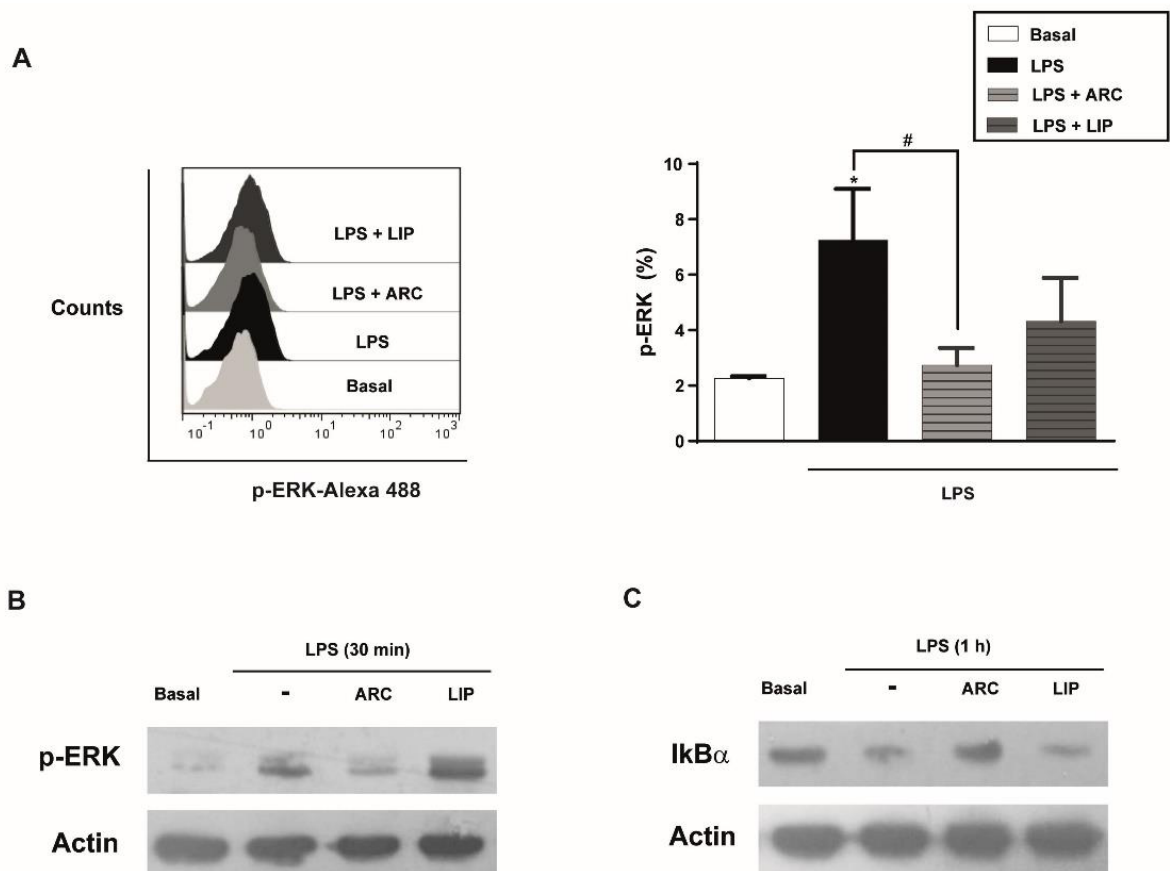
Figure 7. ARC attenuate LPS-induced phosphorylation of extracellular signal-regulated kinase (ERK1/2) and activation of NF- κ B pathway in endothelial cells. ( A ) HMEC were stimulated with LPS (1 µ g/mL) in the absence or presence of nanovesicles for 30 min, labeled with anti-p-ERK and analyzed by flow cytometry (one-way ANOVA followed by Bonferroni multiple comparisons test; * p < 0.05 vs. basal; # p < 0.05 between the labeled groups). HMEC were stimulated with LPS (1 μg /mL) in the absence or presence of nanoarchaeosomes (ARC) or liposomes (LIP) for 30 min ( B ) or 1 h ( C ) and cell extracts were analyzed by Western blot for p- ERK or IkBα, respectively. Representa- tive images.